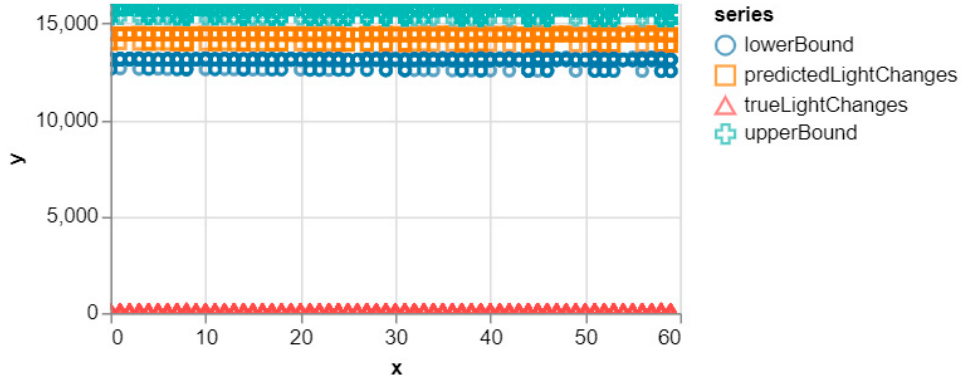
Figure 7. Result of testing the changed model with our default dataset to show the deviations. The x- axis represents the time (sec) while the y-axis represents the light intensity in Lux.